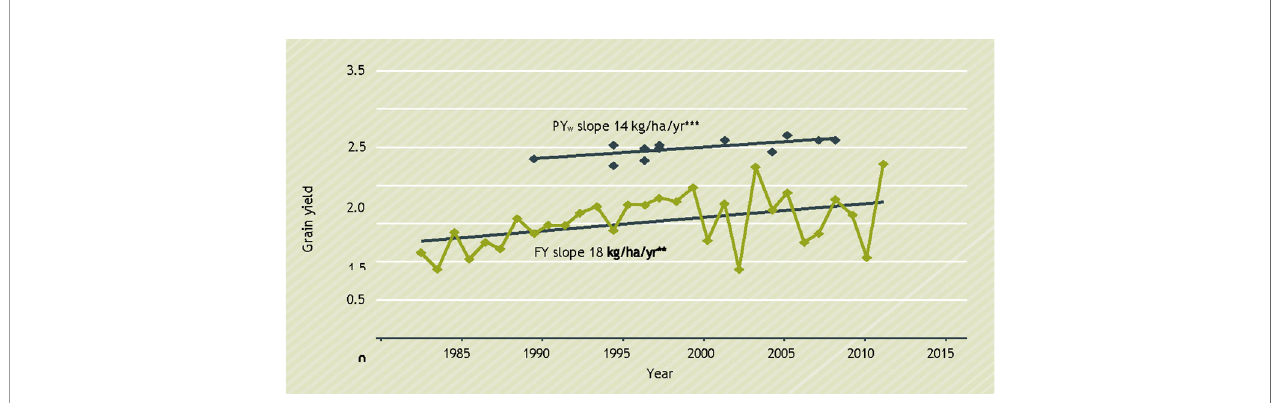
FIGURE 6 | Progress with farm grain yield (FY) and water-limited potential grain yield (PY) of spring wheat in Western Australian over time. PY plot shows progress against year of variety release. The slope difference between FY and PY indicates the yield gap reduction over the years (Source: FY from ABARES (Australian Bureau of Agricultural and Resource Economics and Sciences (2012) and PY from NVT (National Variety Trials) (2009). Adopted from Fischer et al., 2014. **0.01. < P < 0.05, *** P <